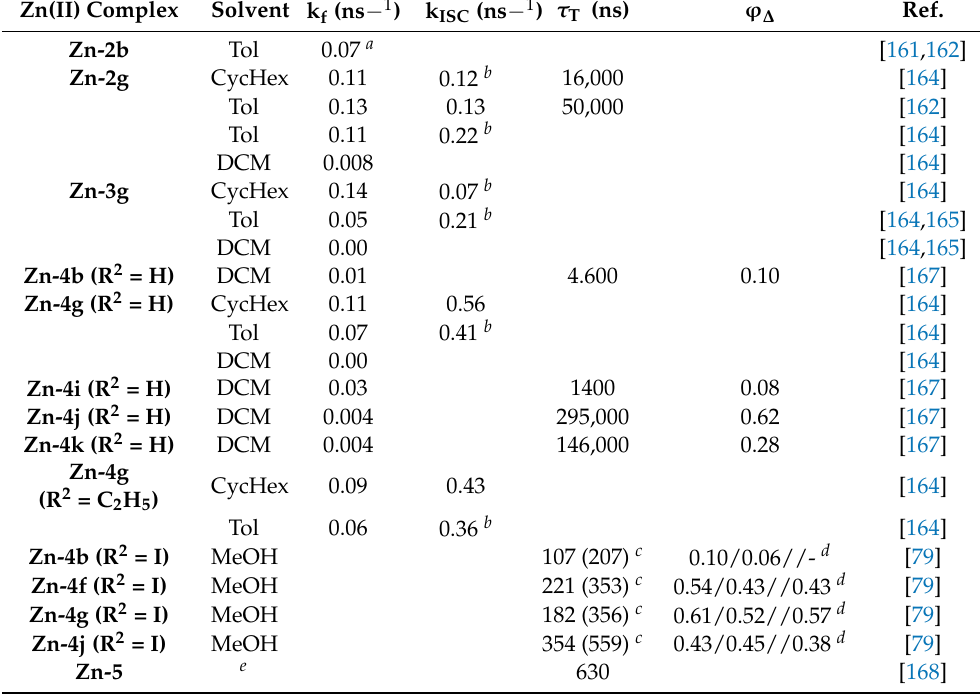
Table A2. Photophysical properties of several homoleptic bis(dipyrrinato)Zn(II) complexes.